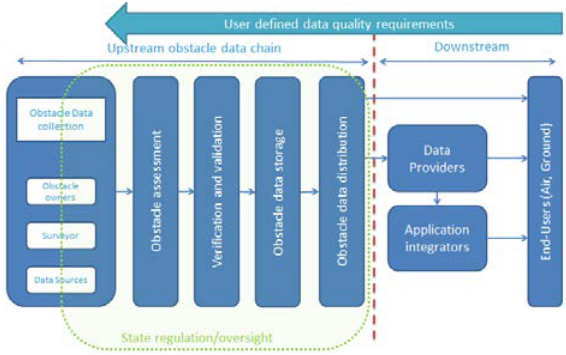
Figure 1. Obstacle data chain (based on EUROCAE ED-76A and Eurocontrol TOD